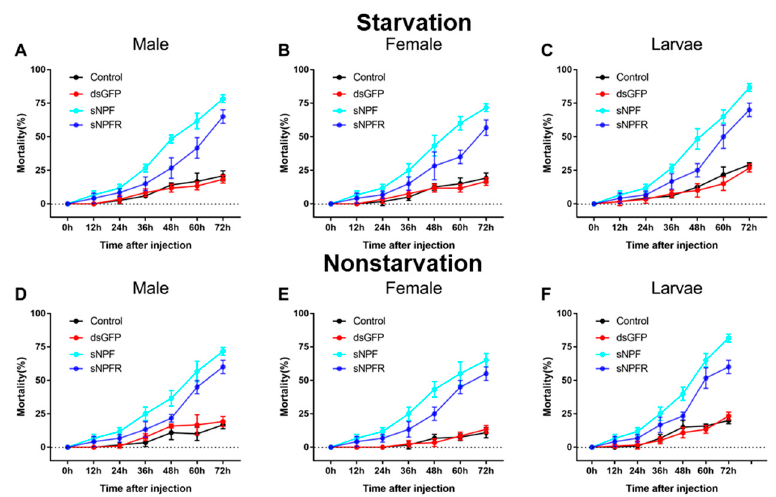
Figure 7. Mortality responses of RNAi D. armandi male ( A ), female ( B ), and larvae ( C ) in